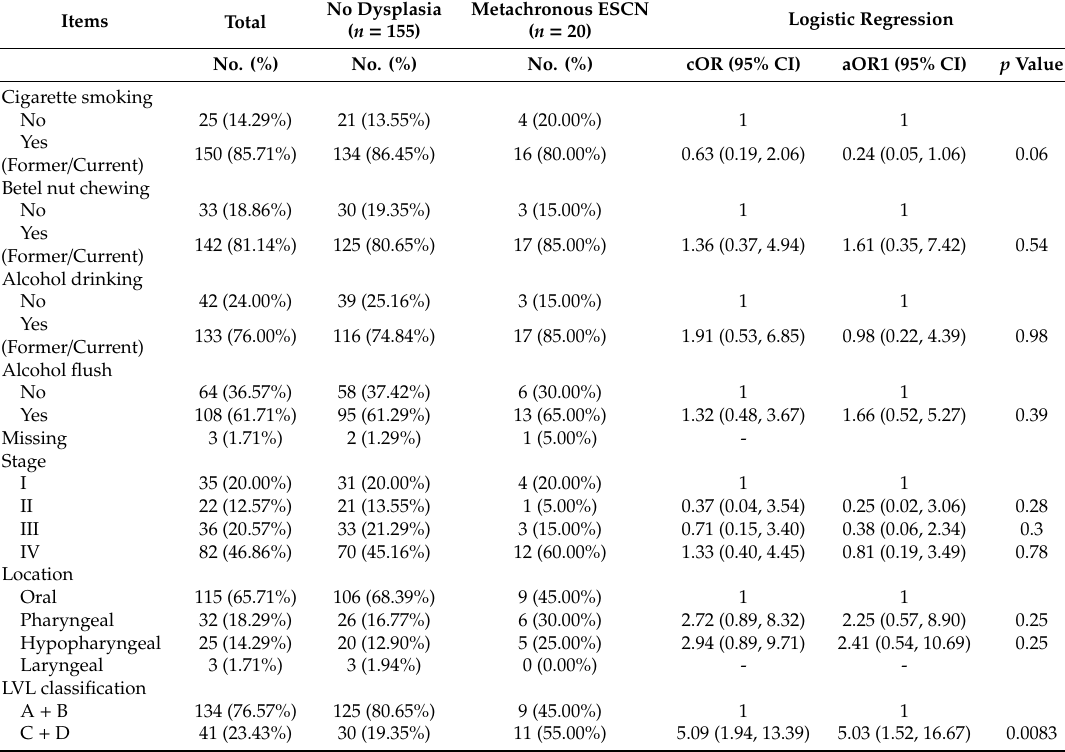
Table 2. Logistic regressions of developing metachronous ESCNs by substance use, index tumor, staging, and LVL